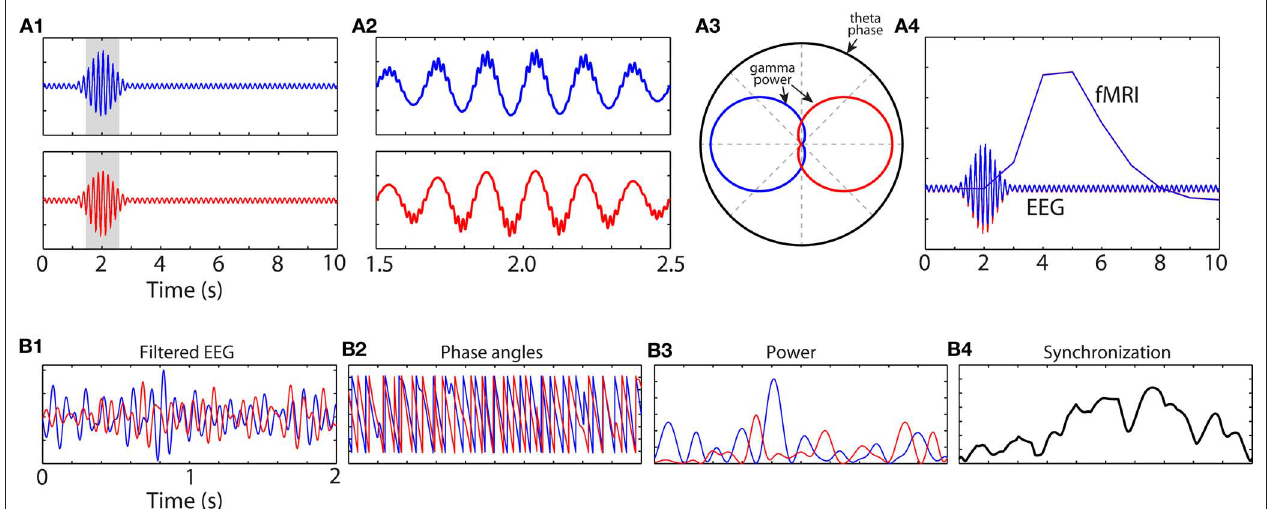
concentrated at different theta phase regions between the conditions (A3) . (A4) shows the predicted hemodynamic response (red and blue lines are overlapping). (B1) Bandpass filtered EEG data from two channels, and (B2) their phase angle time series. (B3) shows band-specific power at each site; note that inter-channel synchronization (B4) does not occur at times of increased power at either site, showing the independence of local activity (B3) and network synchronization (B4)